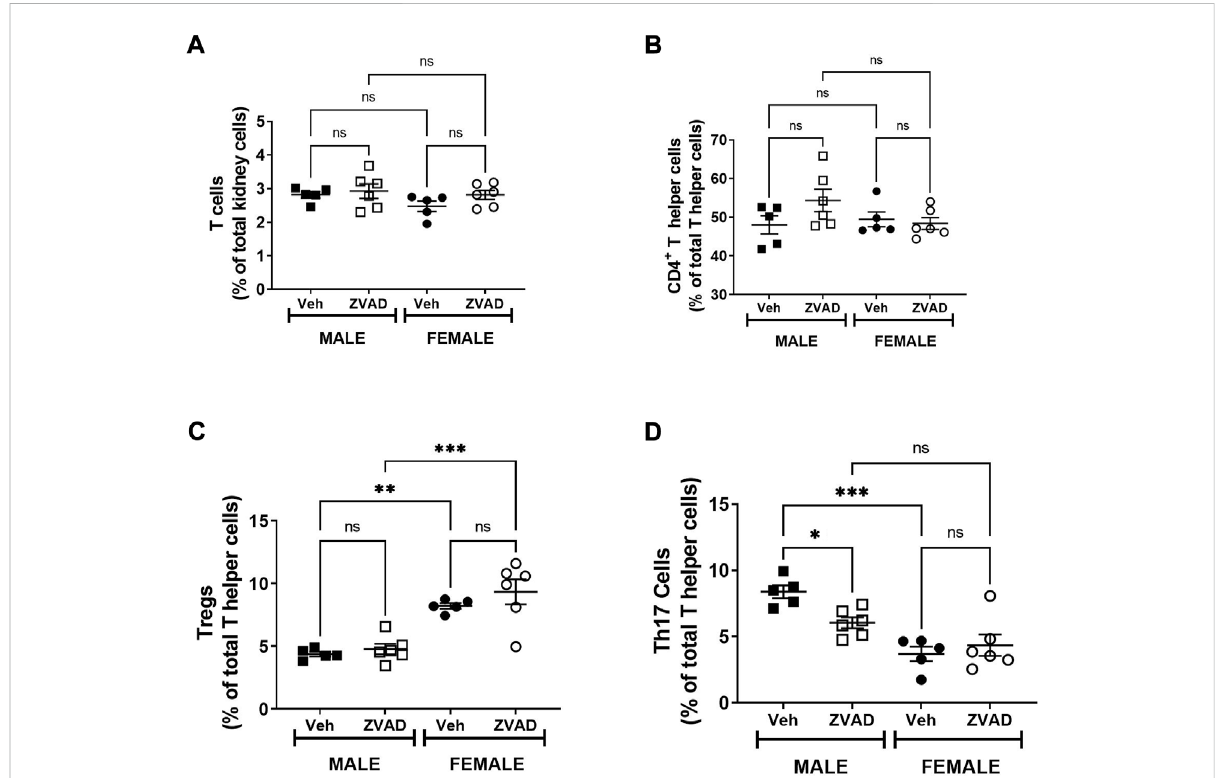
FIGURE 6 Treatment with ZVAD-FMK for 2 weeks decreases Th17 cells in male SHR. T cells were measured in kidneys isolated from male and female spontaneously hypertensive rats (SHR) treated with vehicle (veh) or ZVAD-FMK (ZVAD) from 13 to 15 weeks of age ( n = 5 – 6). The following T cells were measured: total CD3 + T cells [panel (A) ], CD4 + T helper cells [panel (B) ], T regulatory cells [Tregs; CD3 + CD4 + FOXP3 + ; panel (C) ] and T helper [Th17 cells (CD3 + CD4 + ROR- γ + ; panel (D) ]. CD3 + T cells were expressed as % total renal cells. CD4 + T cells were expressed as % total CD3 + T cells. Tregs and Th17 cells were expressed as % CD3 + CD4 + T cells. Data were compared using 2-Way ANOVA followed by Tukey ’ s multiple comparisons test; *** indicates p < 0.001; ** indicates p < 0.01; NS indicates not signi fi